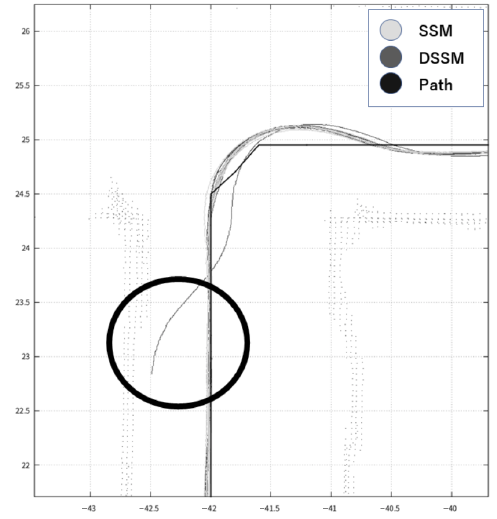
Figure 12. A trajectory recovering the robot